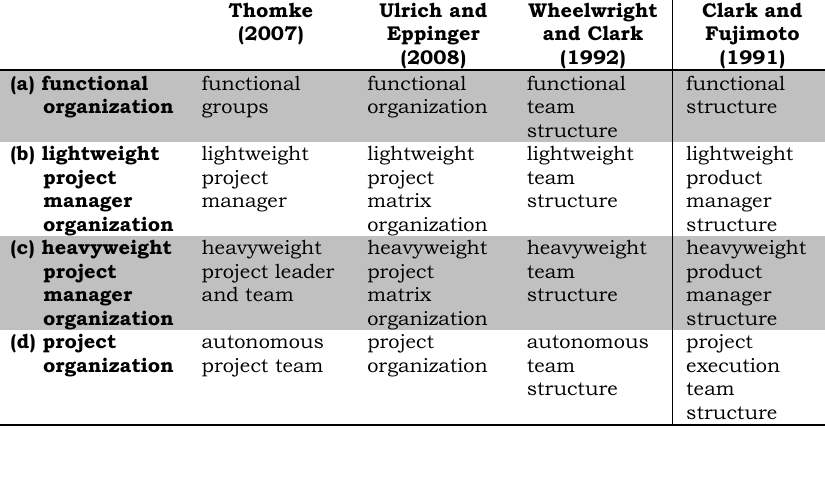
Table 1. Four types of product development organizations